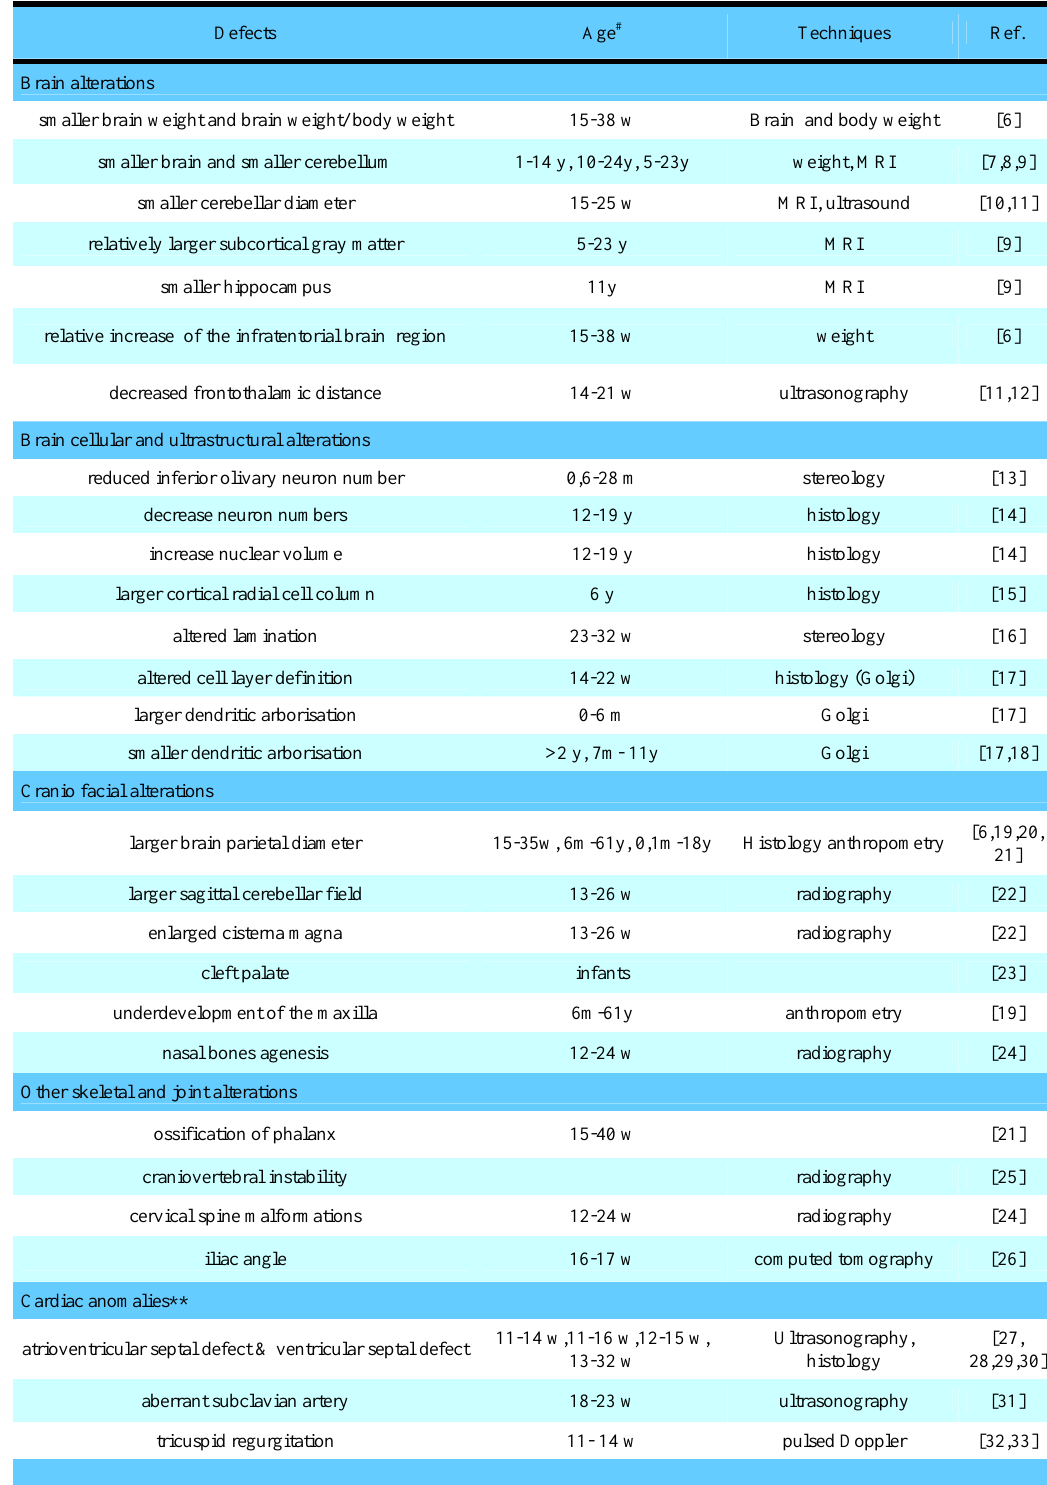
Developmental Defects Associated with T21 Defects Age # Techniques